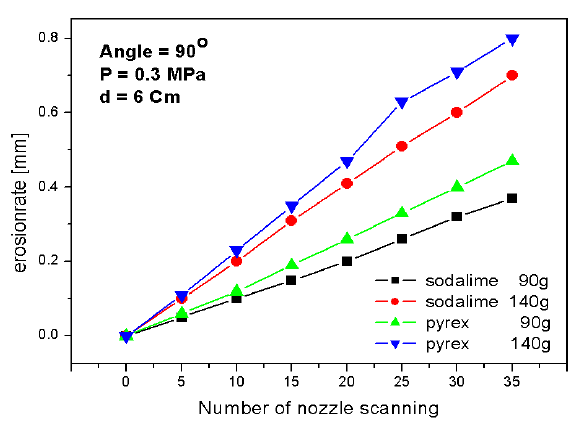
Figure 4. Effects of mass flow rate variation of abrasive.